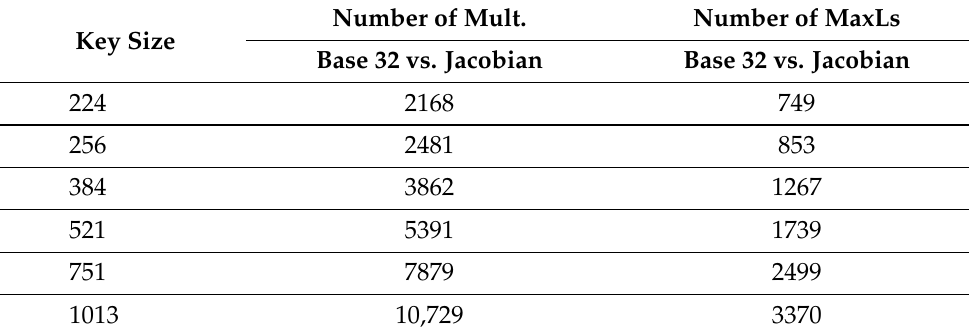
Table 7. ∆ Values for Base 32 vs.